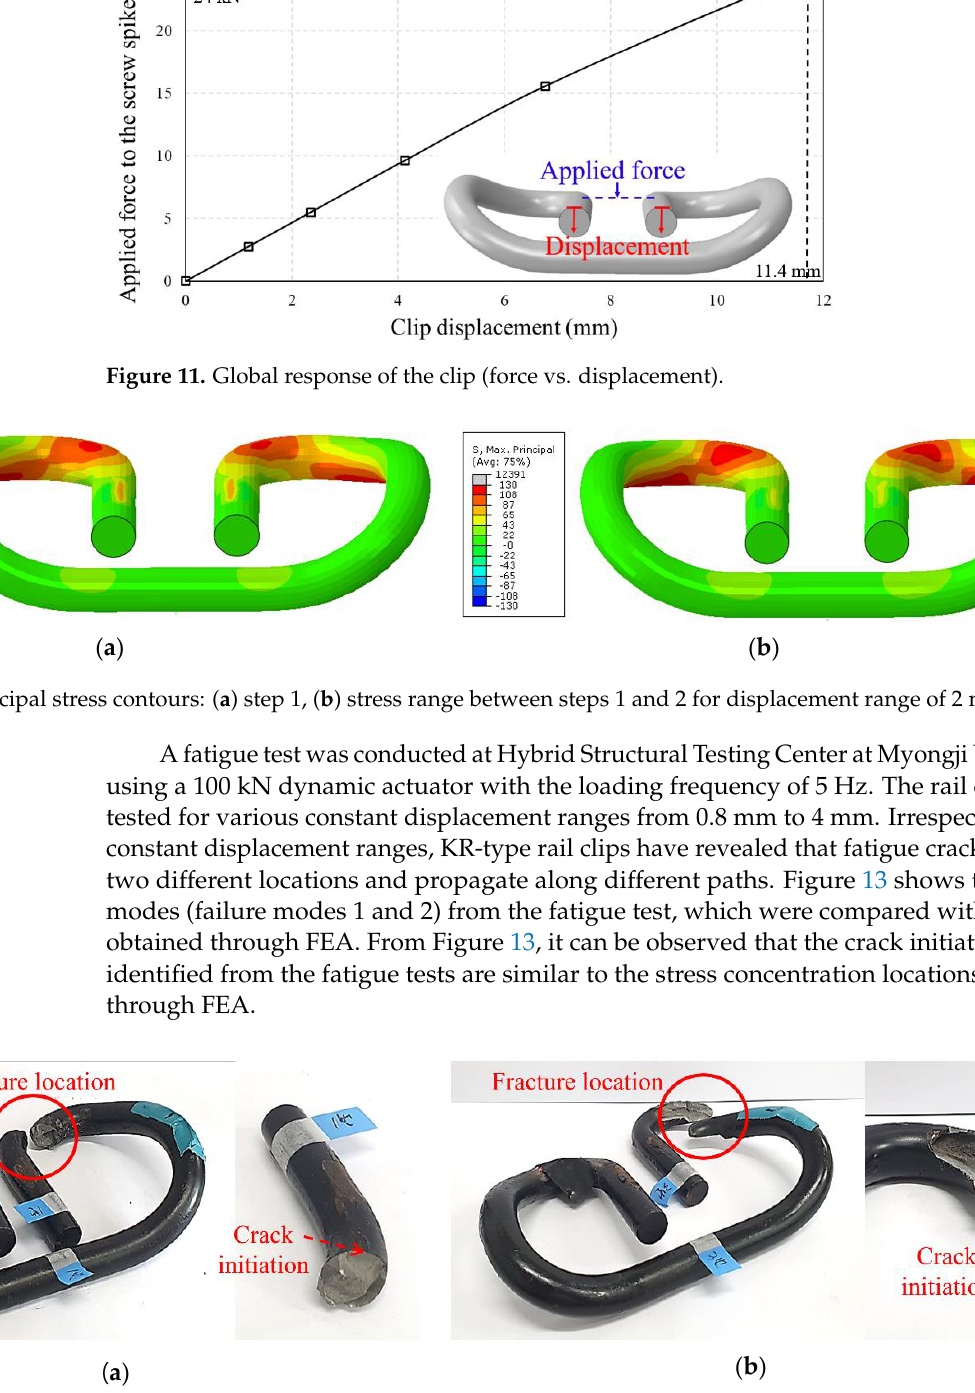
Figure 13. Fatigue failure modes: ( a ) mode 1; ( b ) mode